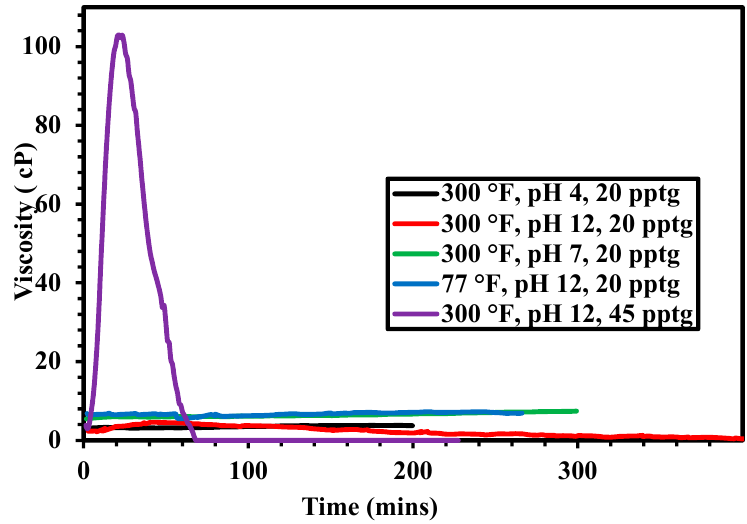
Figure 7. Apparent viscosity of acrylamide (AMPS) polymer with GLDA (20 wt %) at different conditions (Shear rate = 511 s − 1 , P = 300 psi).